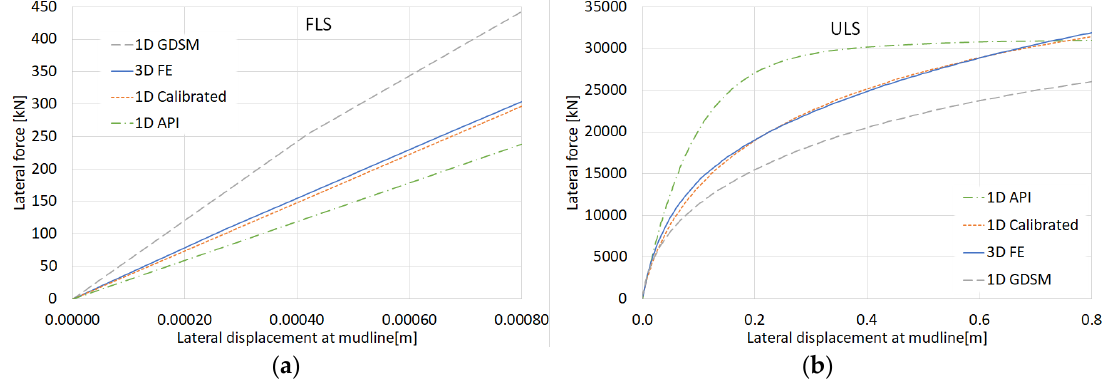
Figure 8. Load-deflection behavior for L = 24 m for different design methods; ( a ) Fatigue Limit State (FLS); ( b ) ULS.